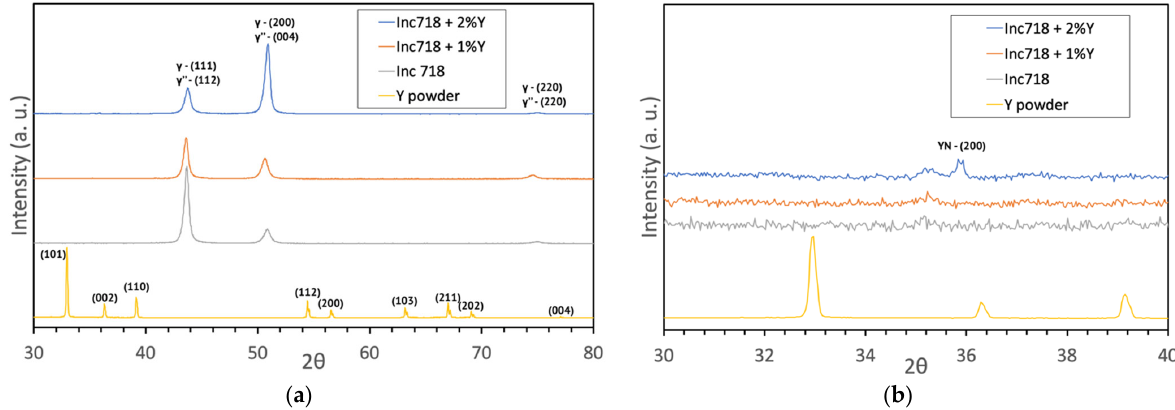
Figure 4. X ‐ ray diffraction patterns of the processed samples ( a ); enlarged part of the graph ( b ).